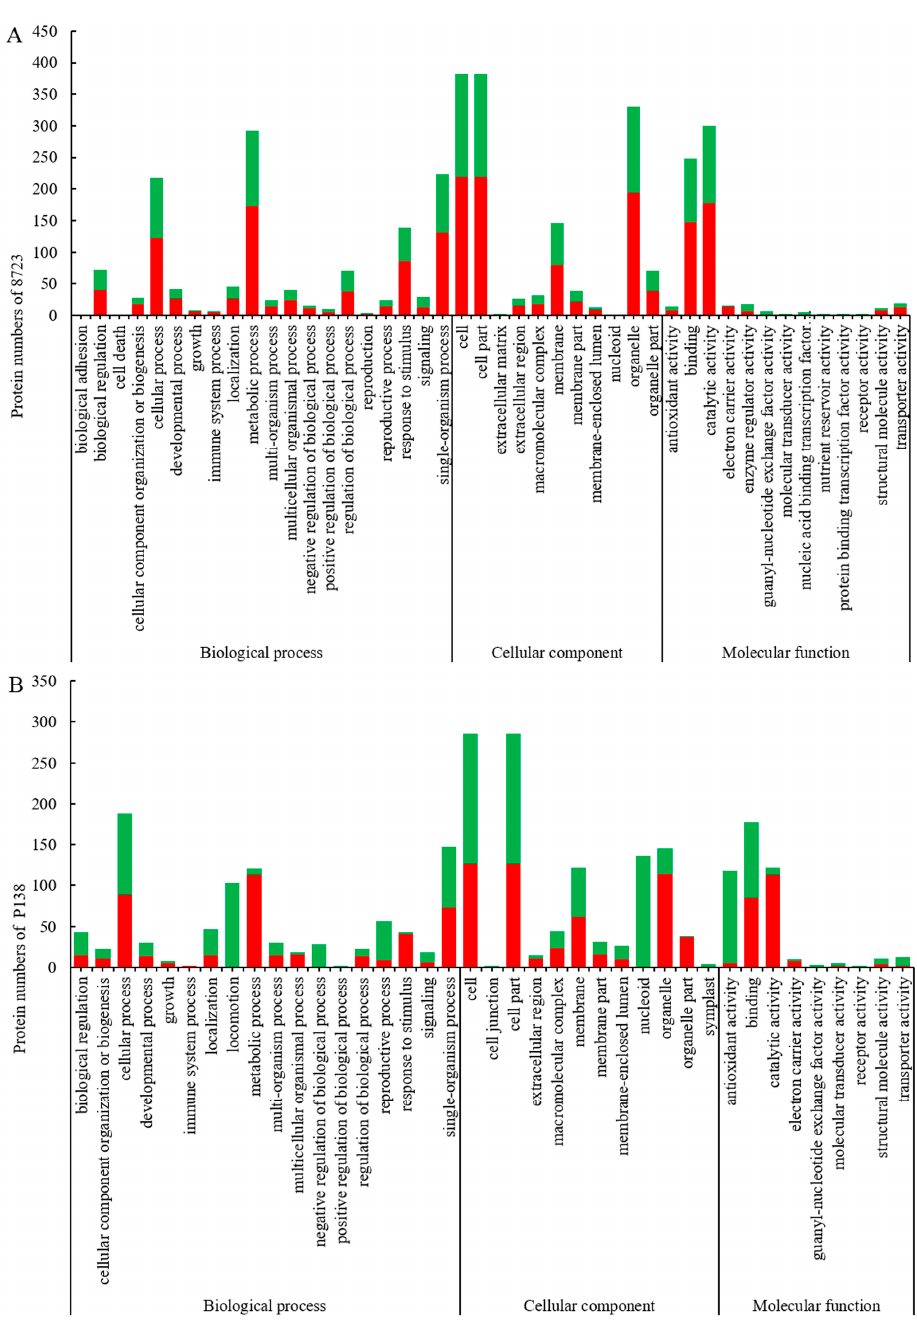
Figure 4. ( A ) Gene ontology (GO) annotation of DEPs in 8723. ( B ) GO annotation of DEPs in P138. Red bars represent increased protein abundances and green represent decreased.